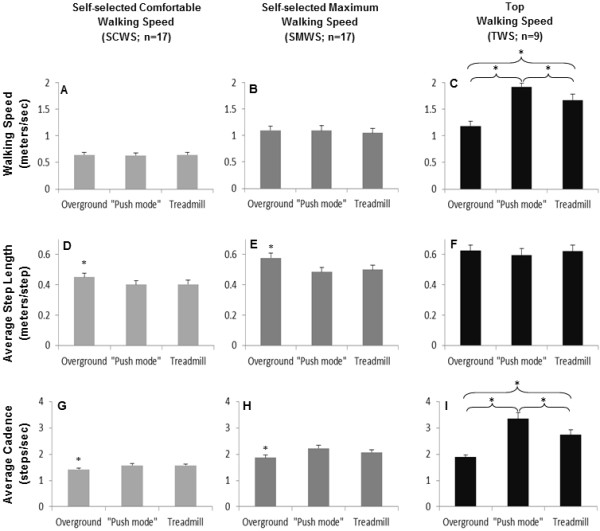
Comparisons between walking speed (A, B, C), average step length (D, E, F), and average cadence (G, H, I) during overground, “push mode”, and treadmill walking at three different speeds. Each column represents mean value ± SEM. Asterisks indicate significant difference (p<0.05) when compared to the other two walking conditions.